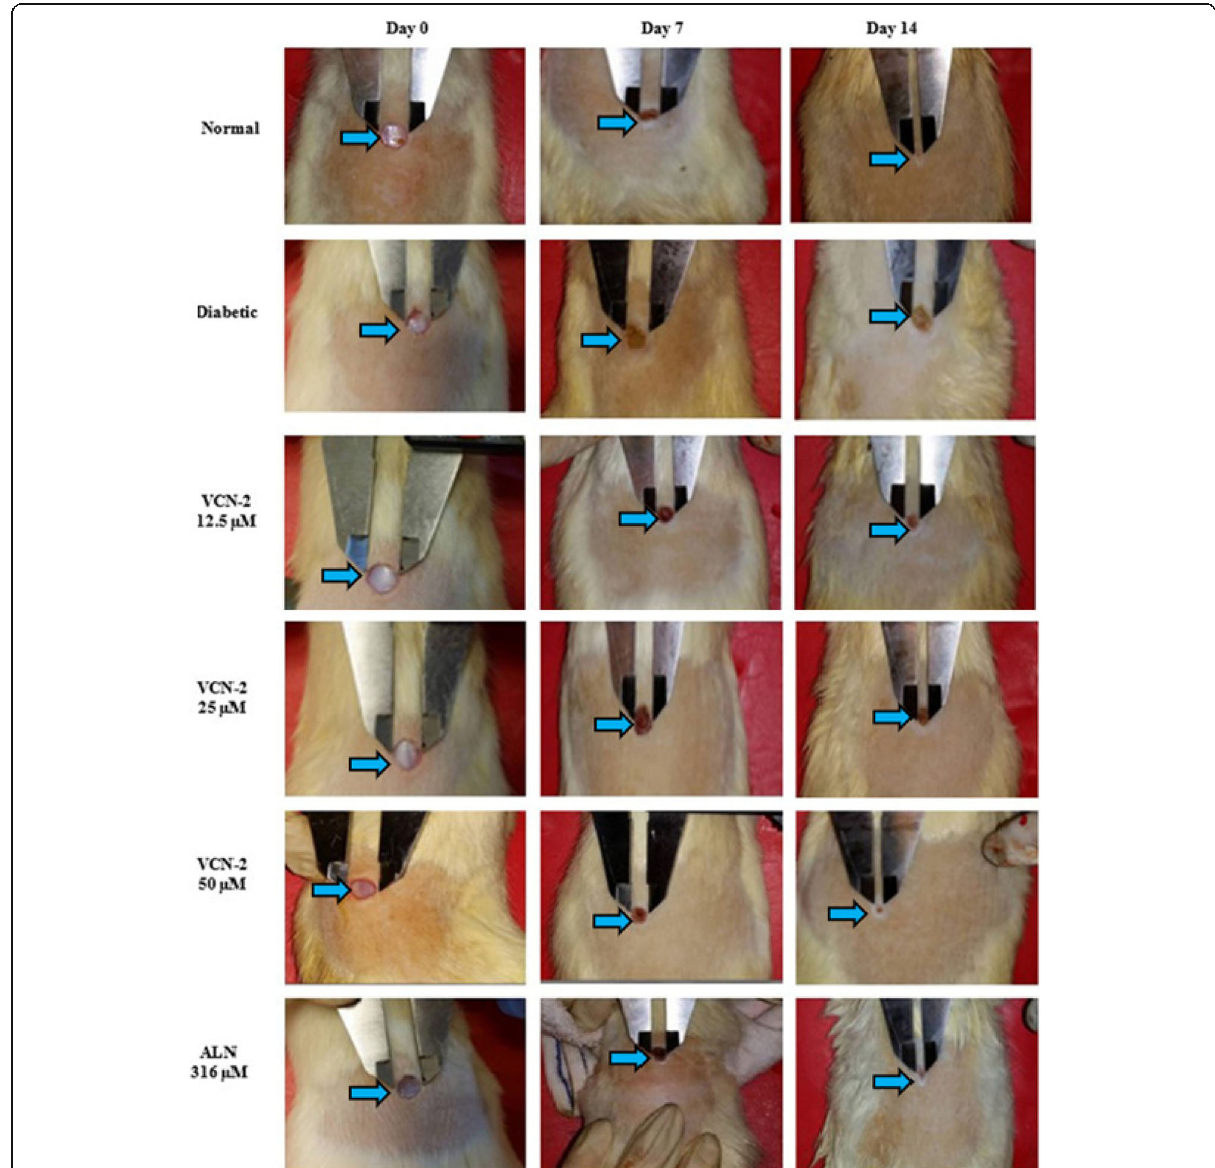
Fig. 1 Representative image of wounds of the normal control, diabetic control, 12.5, 25, 50 μ M VCN-2 and 316 μ M allantoin treated groups on day 0, 7 and 14. Result shows treatment with VCN-2 enhanced wound healing in diabetic rats as compared to diabetic rats treated with blank film ( n =